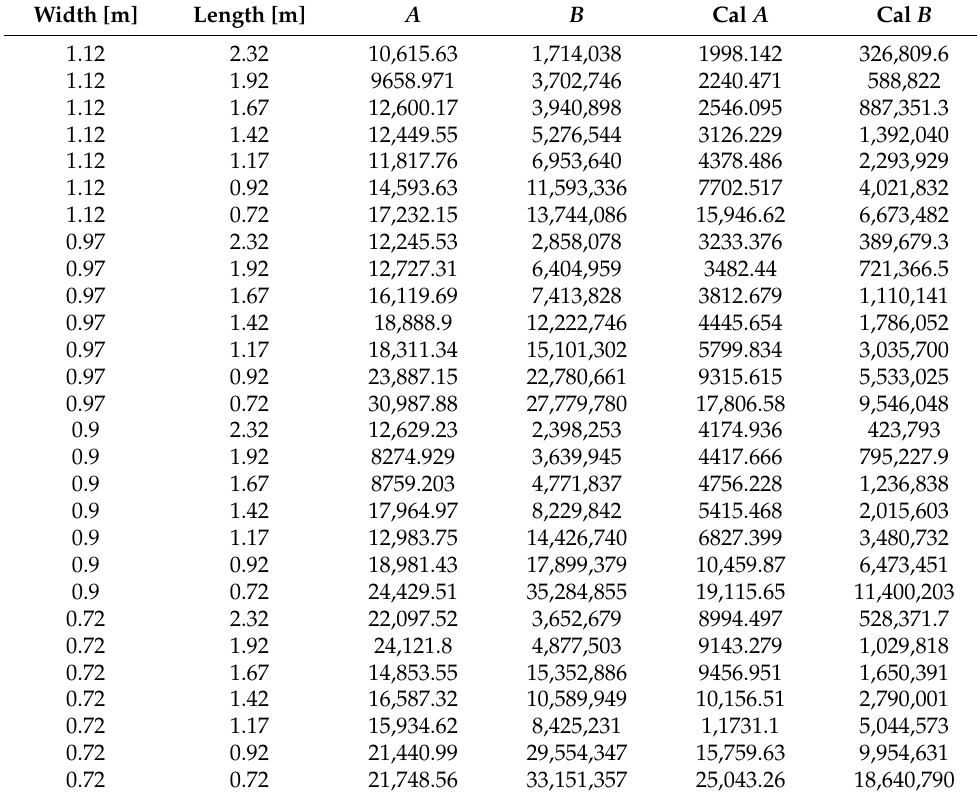
Table A5. The 8 mm plate Polygal vacuum tests A , B and theory calculated A , B